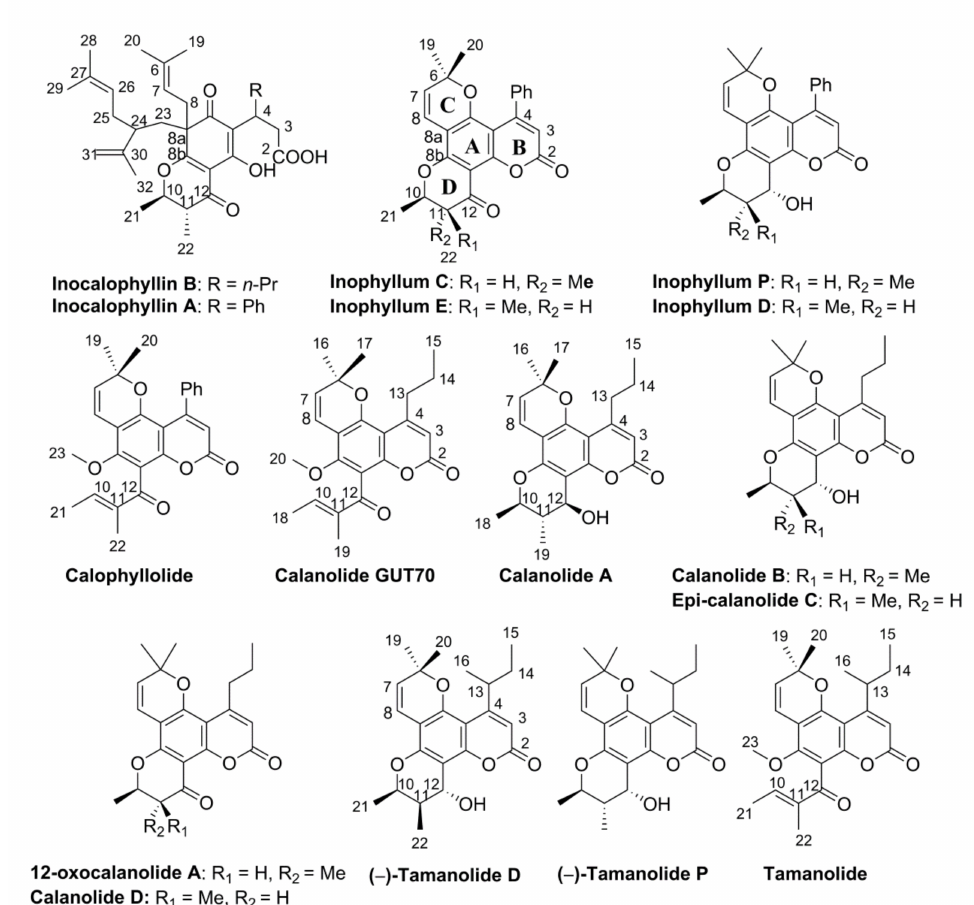
Figure 1. Structure of the secondary metabolites belonging to the pyranocoumarin family isolated from NTR and ATR fractions by low-pressure column chromatography and HPLC separation. 1 H- NMR, 13 C-NMR and MS spectra are reported in Supplementary